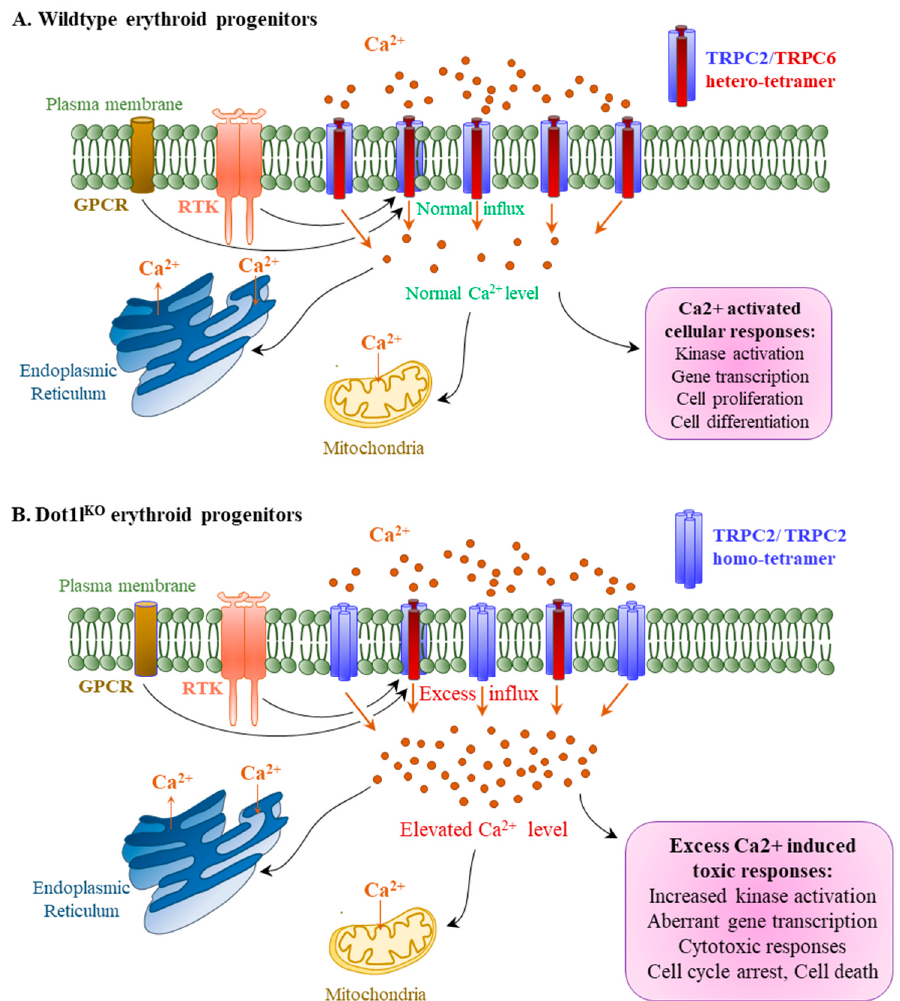
Figure 7. Dot1l KO erythroid progenitors exhibited increased calcium influx following decreased TRPC6 expression. TRPC2 allows Ca 2+ influx into erythroid progenitors. TRPC6 forms a hetero- tetramer with TRPC2 and negatively regulates TRPC2-dependent Ca 2+ influx to maintain the normal intracellular Ca 2+ level ( A ). The loss of DOT1L decreases TRPC6 expression, resulting in an increased TRPC2/TRPC6 ratio. This favors the formation of TRPC2 homo-tetramers over TRPC2/TRPC6 hetero-tetramers leading to an excessive influx of Ca 2+ into Dot1l KO erythroid progenitors ( B ). An elevated Ca 2+ level results in toxic intracellular responses and aberrant cell signaling linked to cell cycle arrest and cell death observed in Dot1l KO erythroid progenitors.